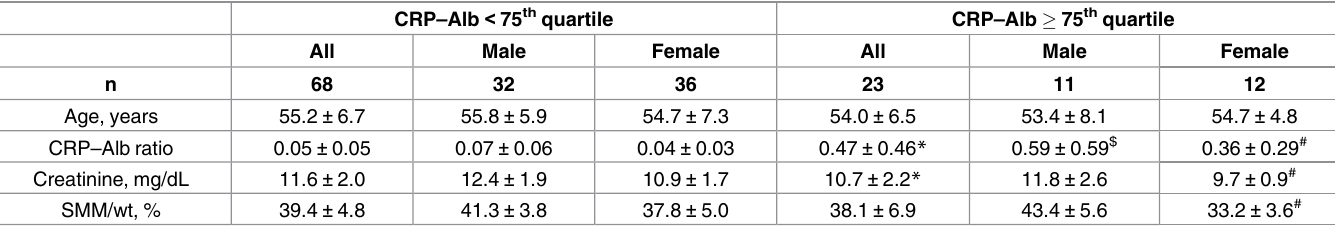
Table 2. Comparison of data stratified by CRP–Alb ratio in 91 consecutive adult patients with HD 1-3 .